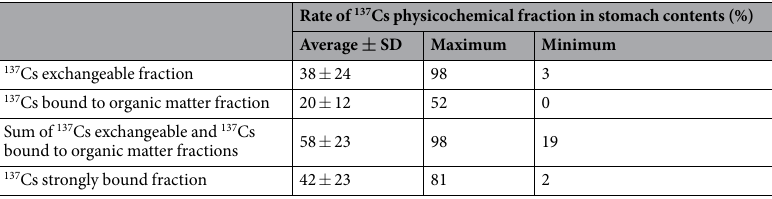
Table 1. Percentage of 137 Cs physicochemical fraction in stomach